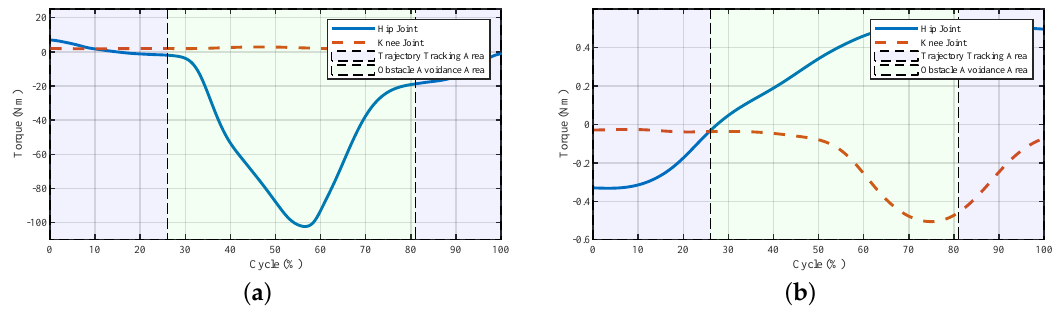
Figure 10. Joint torques of the system used to avoid tripping during stepping over a door threshold. Torques of the ( a ) exoskeleton and ( b )